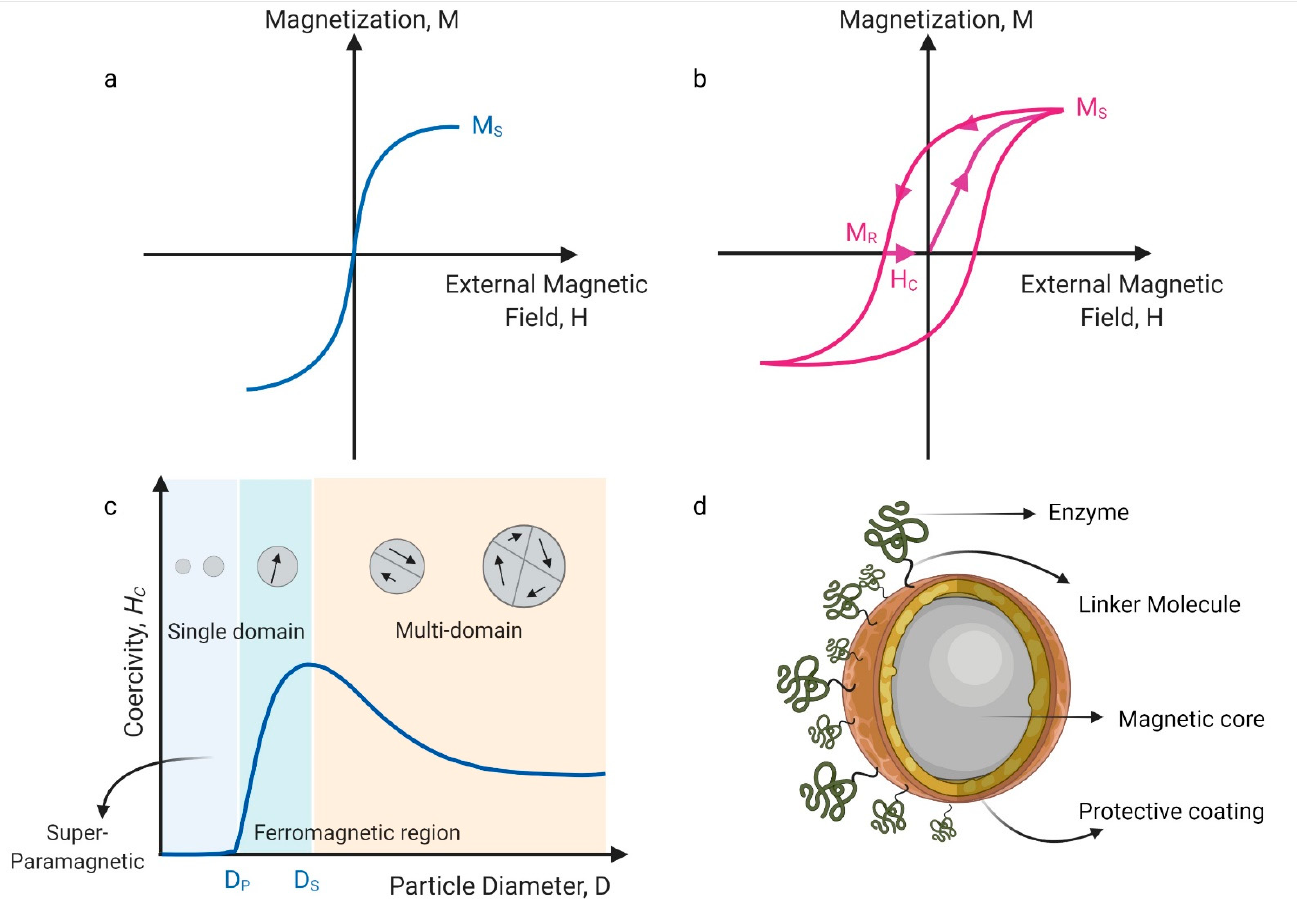
Figure 4. Illustration of magnetic nanoparticles’ physical properties: ( a ) an ideal MNP magnetism in an external magnetic field, ( b ) a real magnetism, where some MNPs agglomerate because of the magnetization and coercivity. M S is saturation magnetization, M R is a remnant magnetization, and H C is coercivity, ( c ) small MNPs show fast response to an external magnetic field because of their size and a lower energy barrier that allows coherent and independent vectorial rotation. MNPs are difficult to demagnetize. ( d ) MNP typical structure shows a magnetic core, an inert shell, and enzymes attached to the MNP surface using a suitable linker.